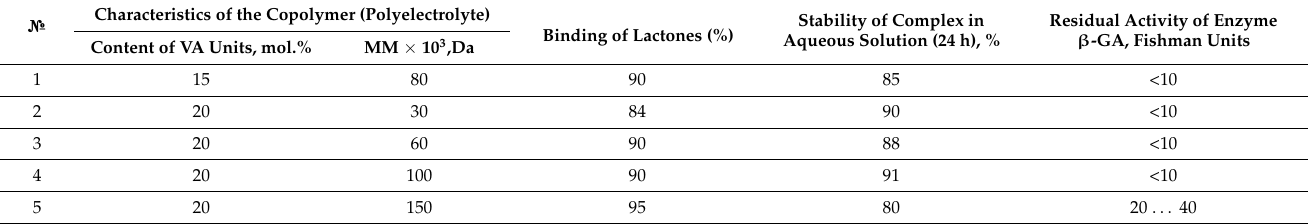
Table 6. Influence of copolymer composition and its molecular mass on specific activity and stability of complexes.